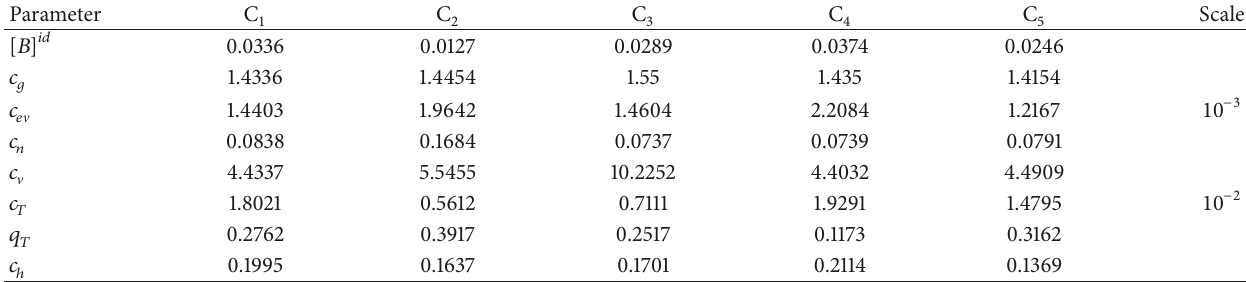
Table 8: Model parameter values resulting from fitting to individual trajectories in the case of therapy 1 (mice C 1 -C 5 ).